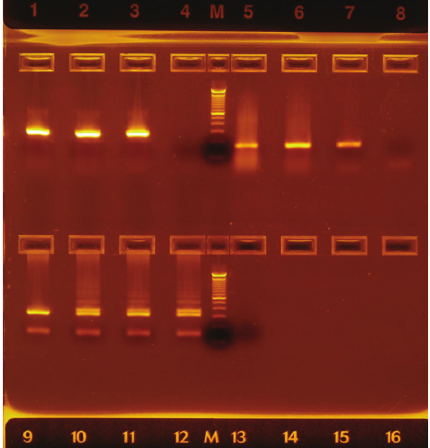
Figure 1: Reverse transcriptase-polymerase chain reaction (RT- PCR) and PCR for the evaluation of bone marrow samples from two APL patients. Upper panel: lanes 1 and 2: transcripts of the bcr-3 isoform in patients; lane 3: bcr-3 positive control; lane 4: no template control; M: molecular weight marker; lanes 5 and 6: primers specific for the RARA gene used for control of cDNA quality in each patient; lane 7: RARA positive control; lane 8: no template control. Lower panel: lanes 10 and 11: patients with an FLT3 ITD mutation; lane 9: normal individual; lane 12: FLT3 ITD positive control; lane 13: no template control; M: molecular weight